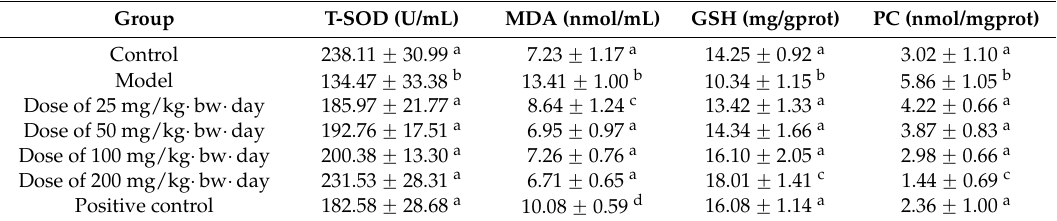
Table 5. Effect of FSM on the activity of total superoxide dismutase (T-SOD), the content of malondialdehyde (MDA) in serum and the content of antioxidant, glutathione (GSH), protein carbonyl (PC) in liver